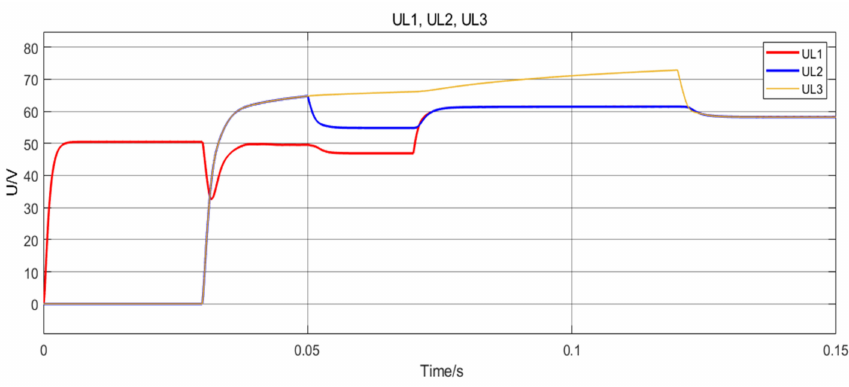
Figure 11. Simulation diagram of output voltage changes of load #1, load #2 and load